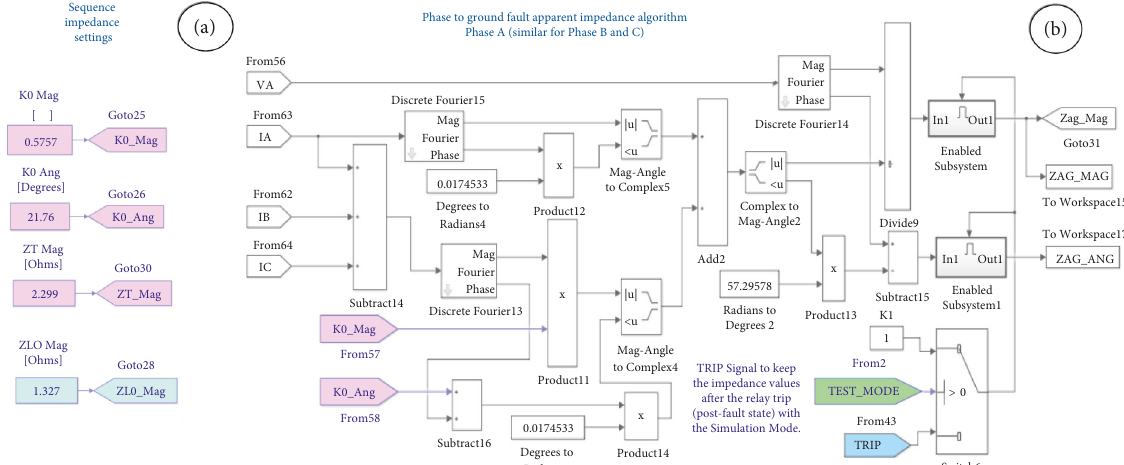
Figure 5: Model with (a) sequence impedance settings and (b) PGFA impedance algorithm block.